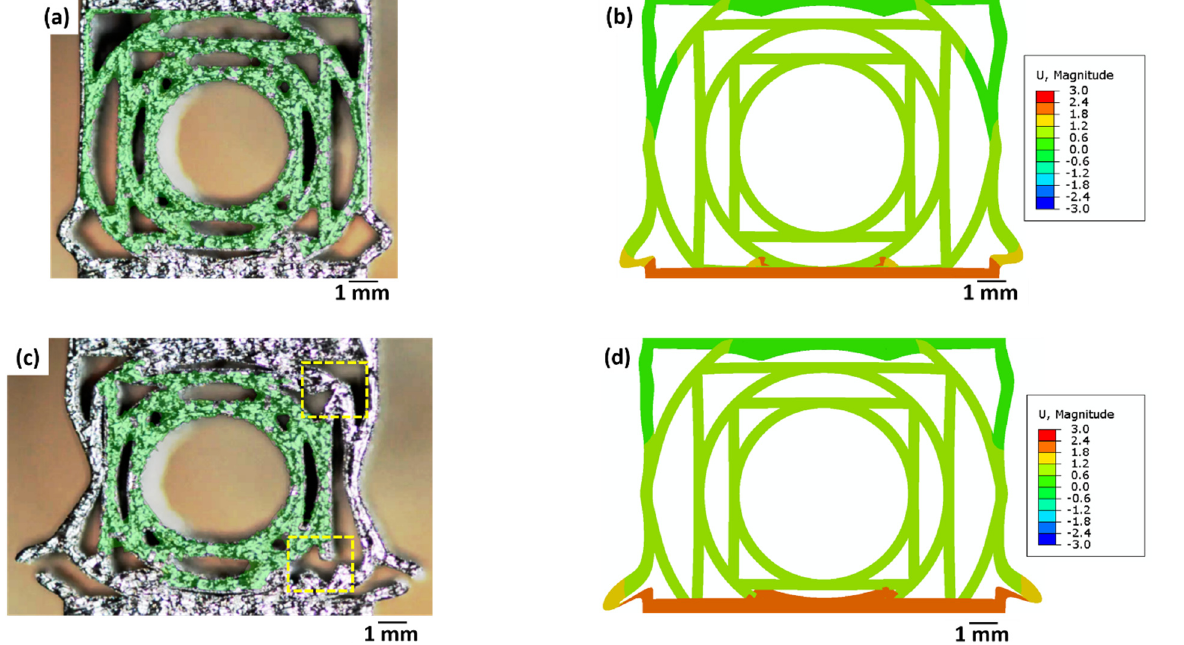
Figure 6. Strain distribution in the nested cellular solid was measured by ( a , c ) DIC; and ( b , d ) FEM simulation. The strain distribution in ( a , b ) is plotted at 12% strain (green point 2, Figure 4a), and the strain distribution in ( c , d ) is plotted at 16% strain (green point 4, Figure 4a). Yellow rectangles in ( c ) highlight the failure of nodes; FEM simulations predict only strain magnitudes.